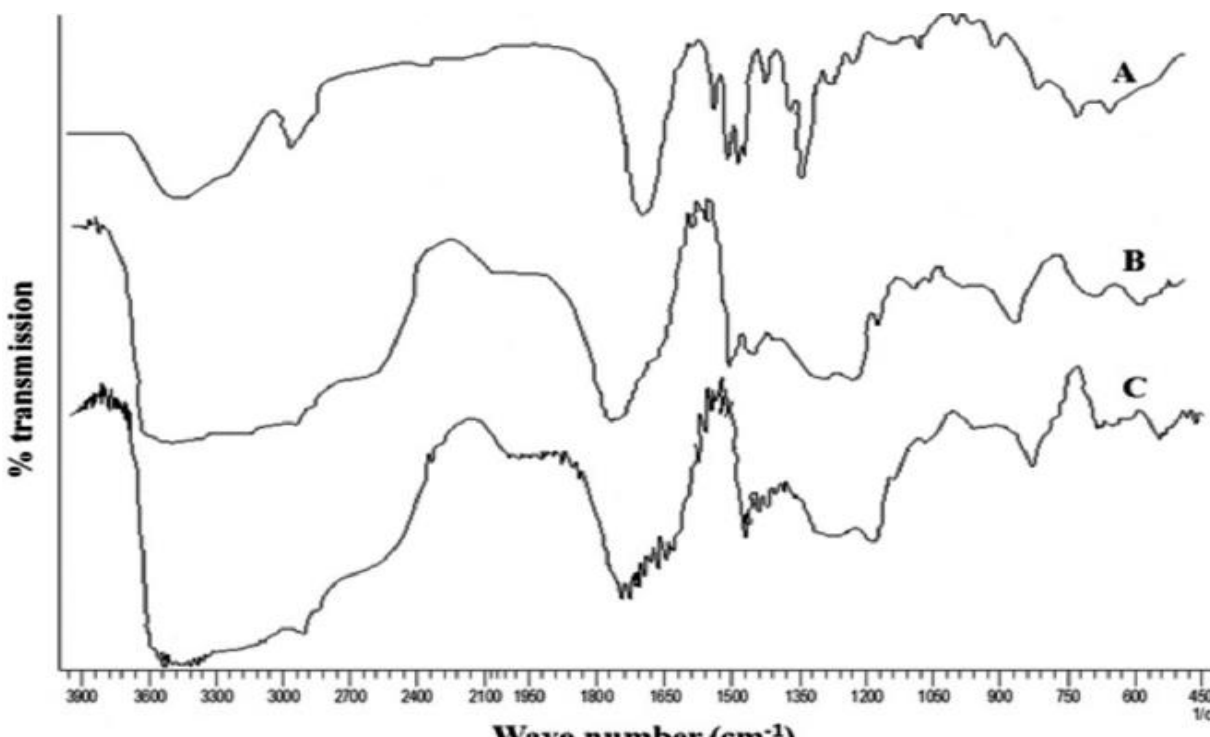
Fig. 5. FT-IR spectra for (A) Polyvinylpyrrolidone, (B) acrylic acid and (C) Polyvinylpyrrolidone/acrylic acid